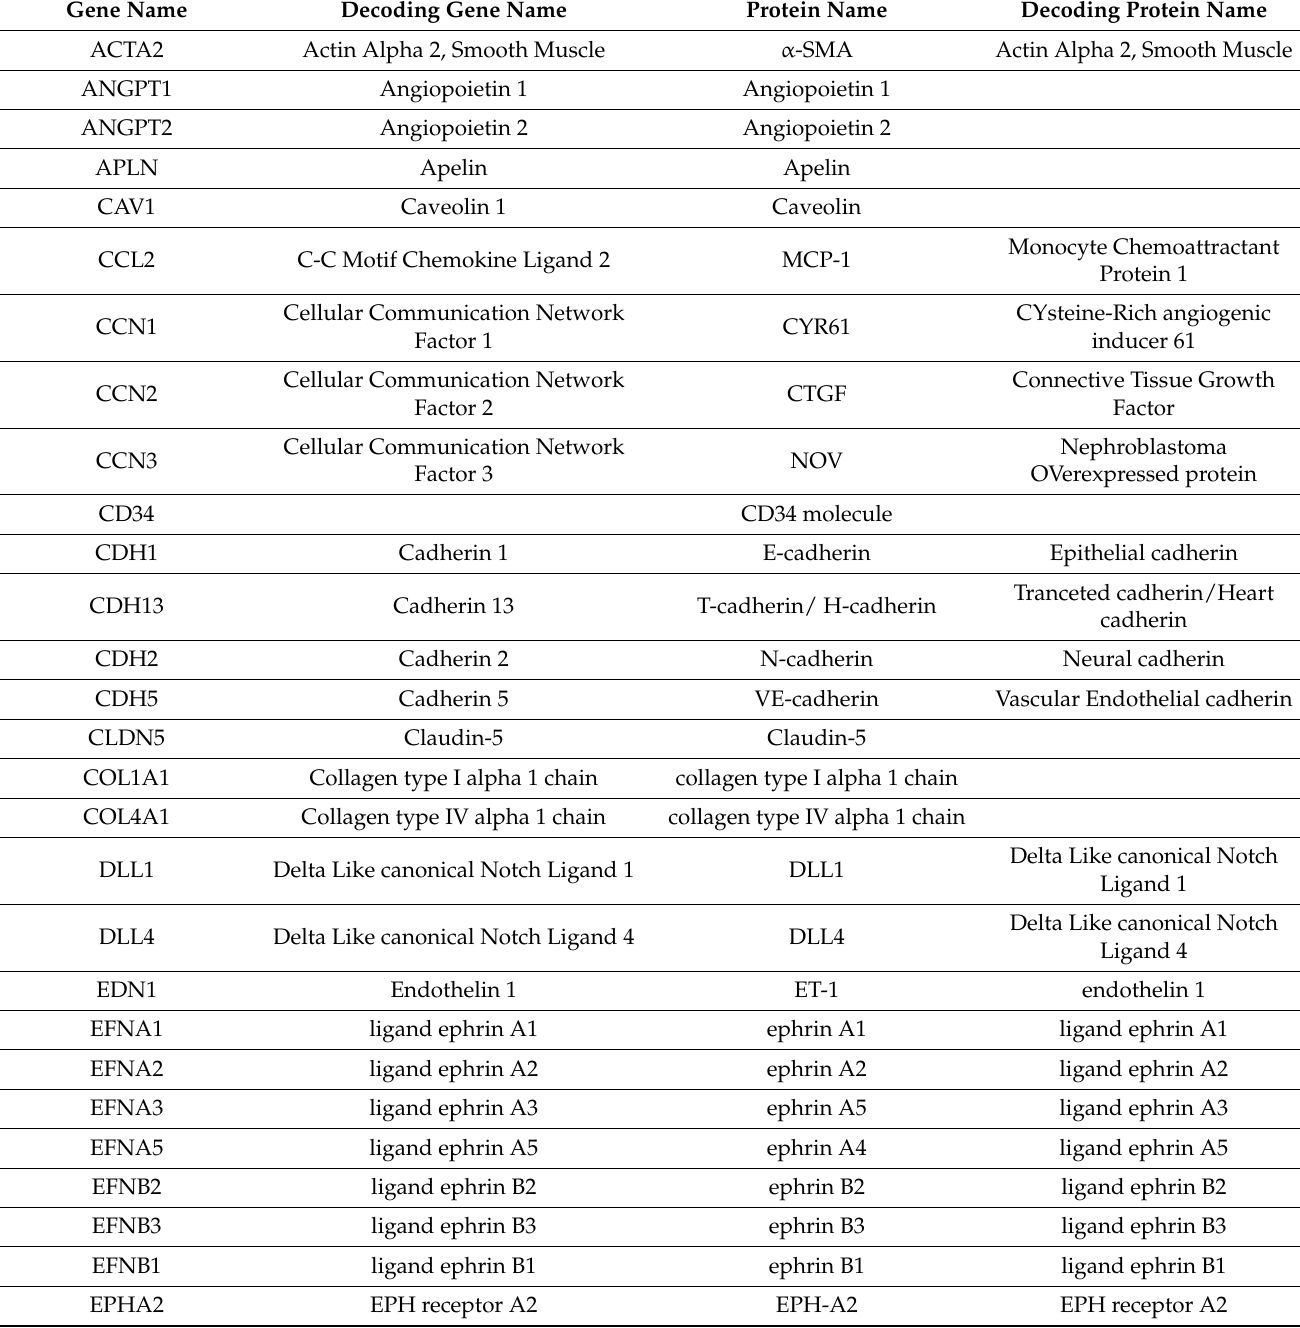
Table 2. Genes and corresponding